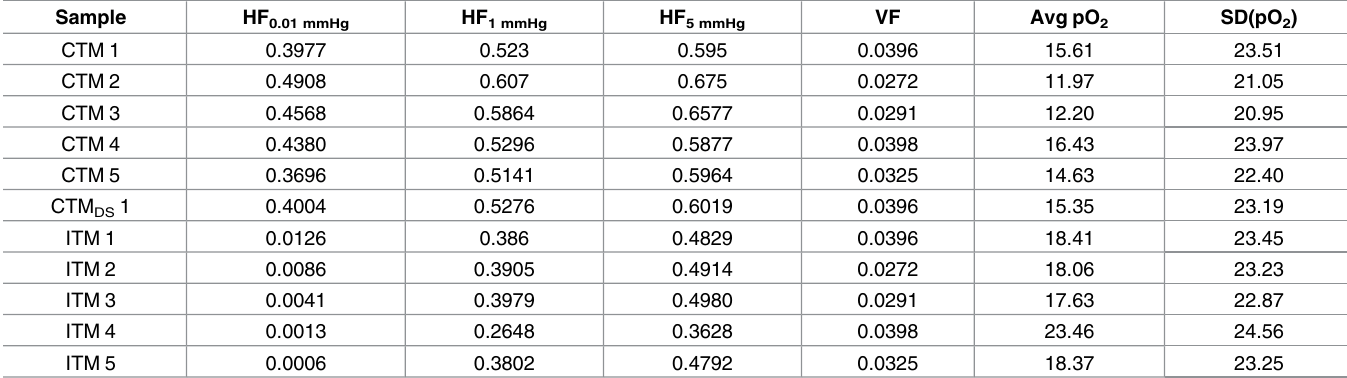
Table 2. The vascularfractions, hypoxic fractions with threshold levels 0.01, 1 and 5 mmHg and averagevalue and standard deviation of pO 2 for five samples from the CTM and the corresponding samples from the ITM. Sample